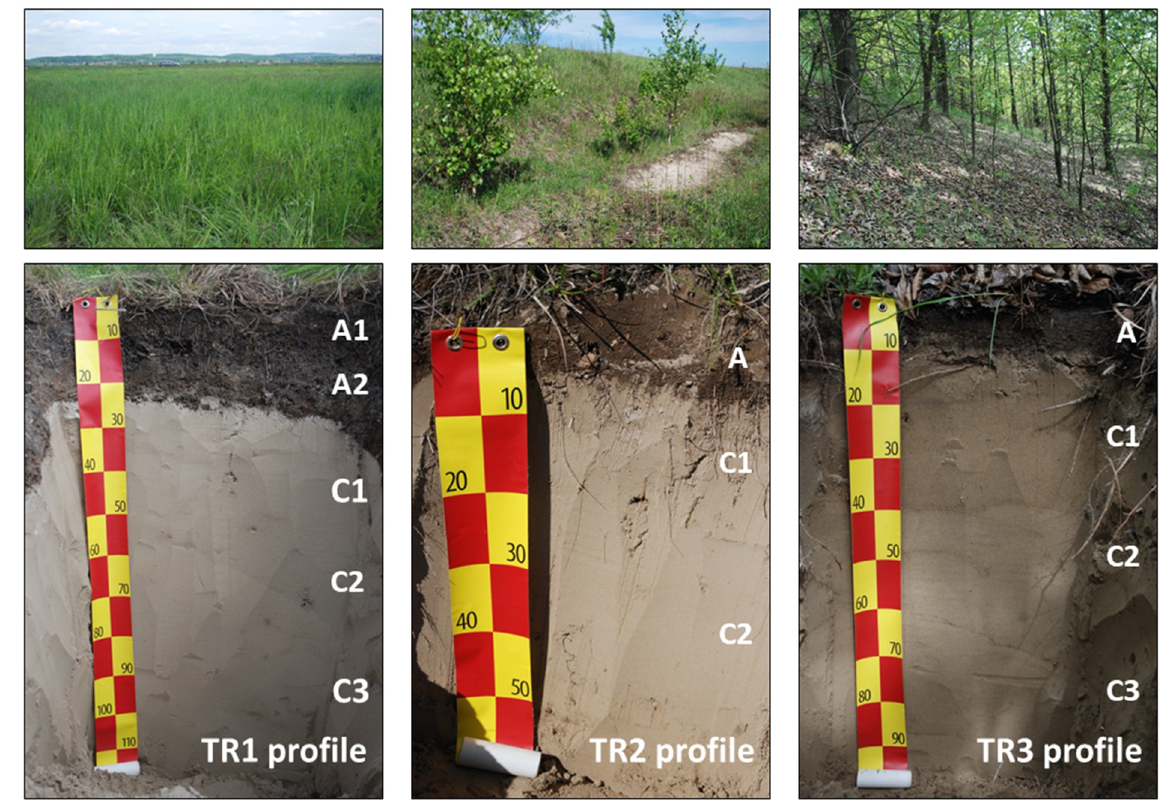
Figure 2. Studied soil profiles and their surroundings.